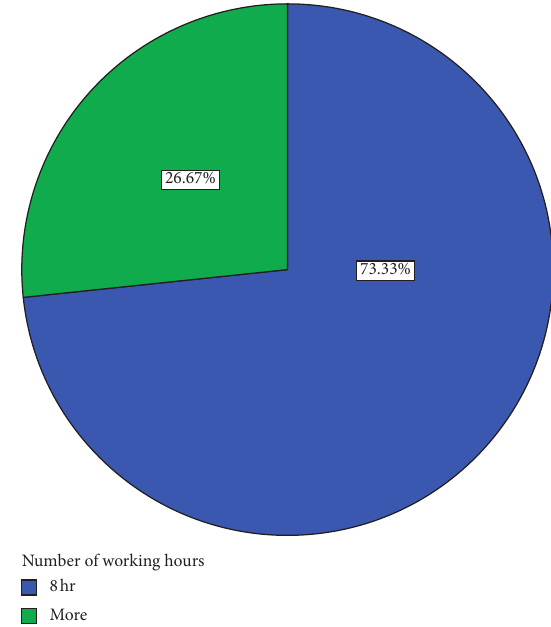
Figure 3: Distribution of marital status of participants.